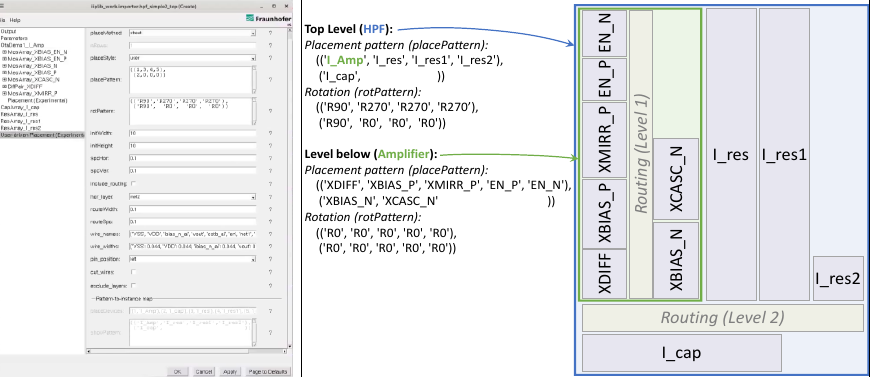
Figure 10. GUI of the hierarchical template-based generator ( left ) and the corresponding representation with illustrated hierarchy ( right ). Based on the hierarchical parameters for placement method ( placeMethod , here the template called “street”), instance place pattern ( placePattern ), wire names ( wire_names ), and rotation pattern ( rotPattern ), the abstract template illustrated on the right is fully represented. Upon generation, the building blocks are generated and the predefined template controls the layout placement and routing process starting from the lower level generators including the amplifier towards the top-level generator.